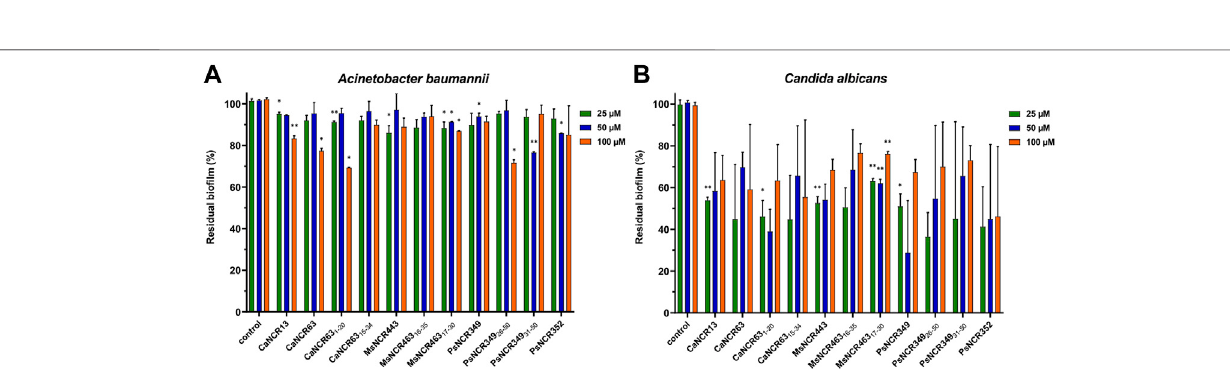
( Figure 1B ) indicate higher possibility for antimicrobial activity likely due to adoption of secondary structures at membrane-water interphases (Vishnepolsky and Pirtskhalava, 2014; Pirtskhalava et al., 2021).